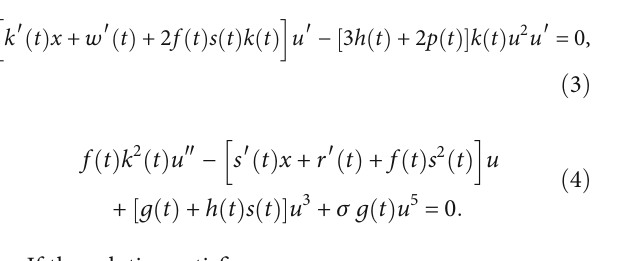
Figure 3: (a – c) The 3D wave shapes of j q j : (a) f ð t Þ = 1 , (b) f ð t Þ = t , and (c) f ð t Þ = 1/ ð 1 + t Þ . (d) The wave propagates along the x